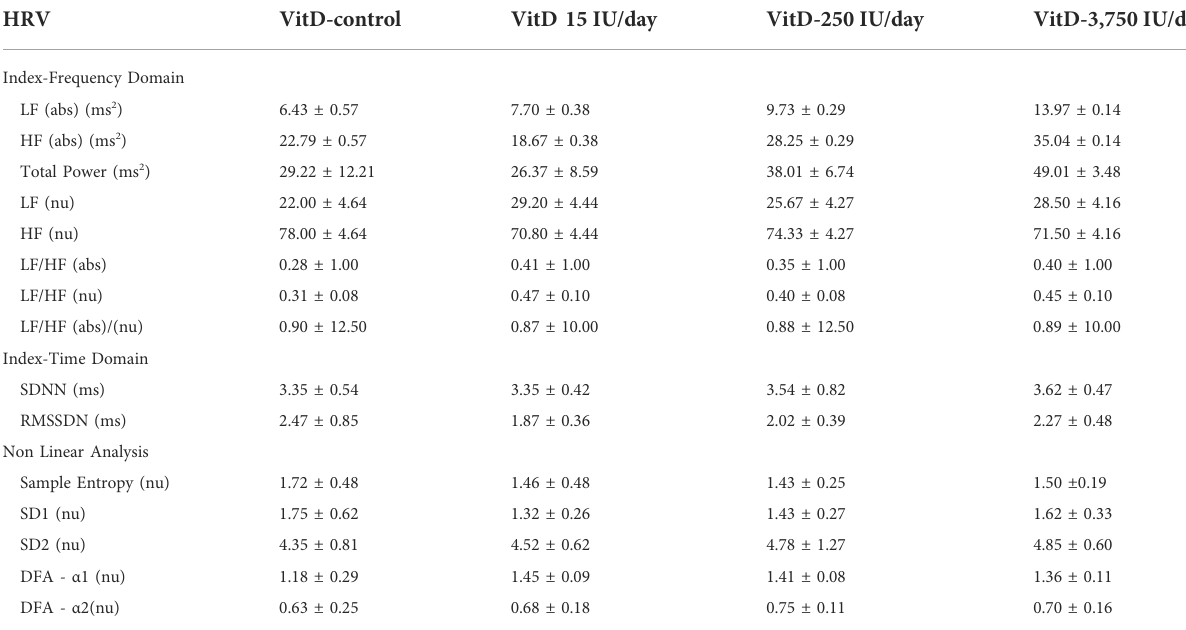
TABLE 1 Index of heart rate variability